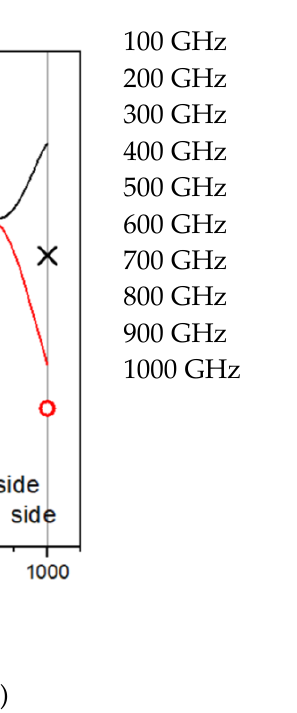
Figure 11. Calculated dependence of film characteristics on surface roughness: ( a ) dependence of effective conductivity on frequency for film with roughness of 2.5 μ m; ( b ) absorbance coefficient of thin film at different frequencies depending on value of effective conductivity.